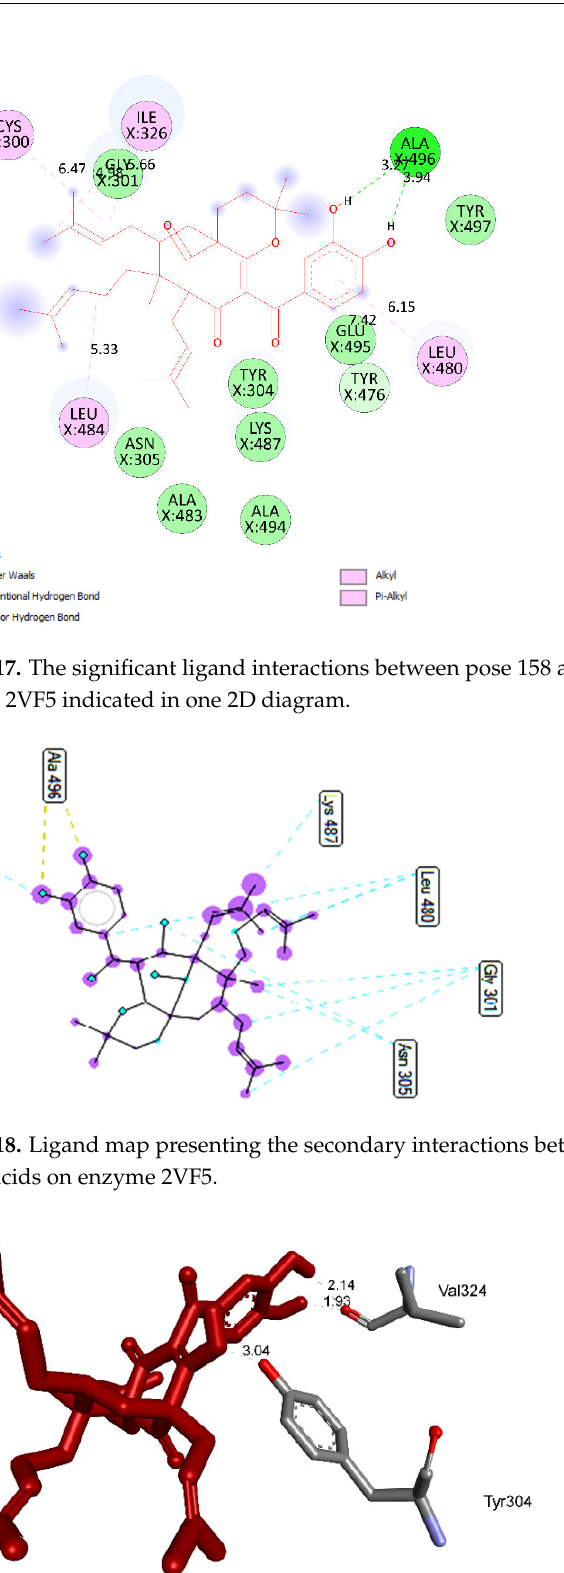
Figure 19. The hydrogen bonds from active atoms on pose 35/200 to active atoms on residual amino acids of enzyme 2VF5.